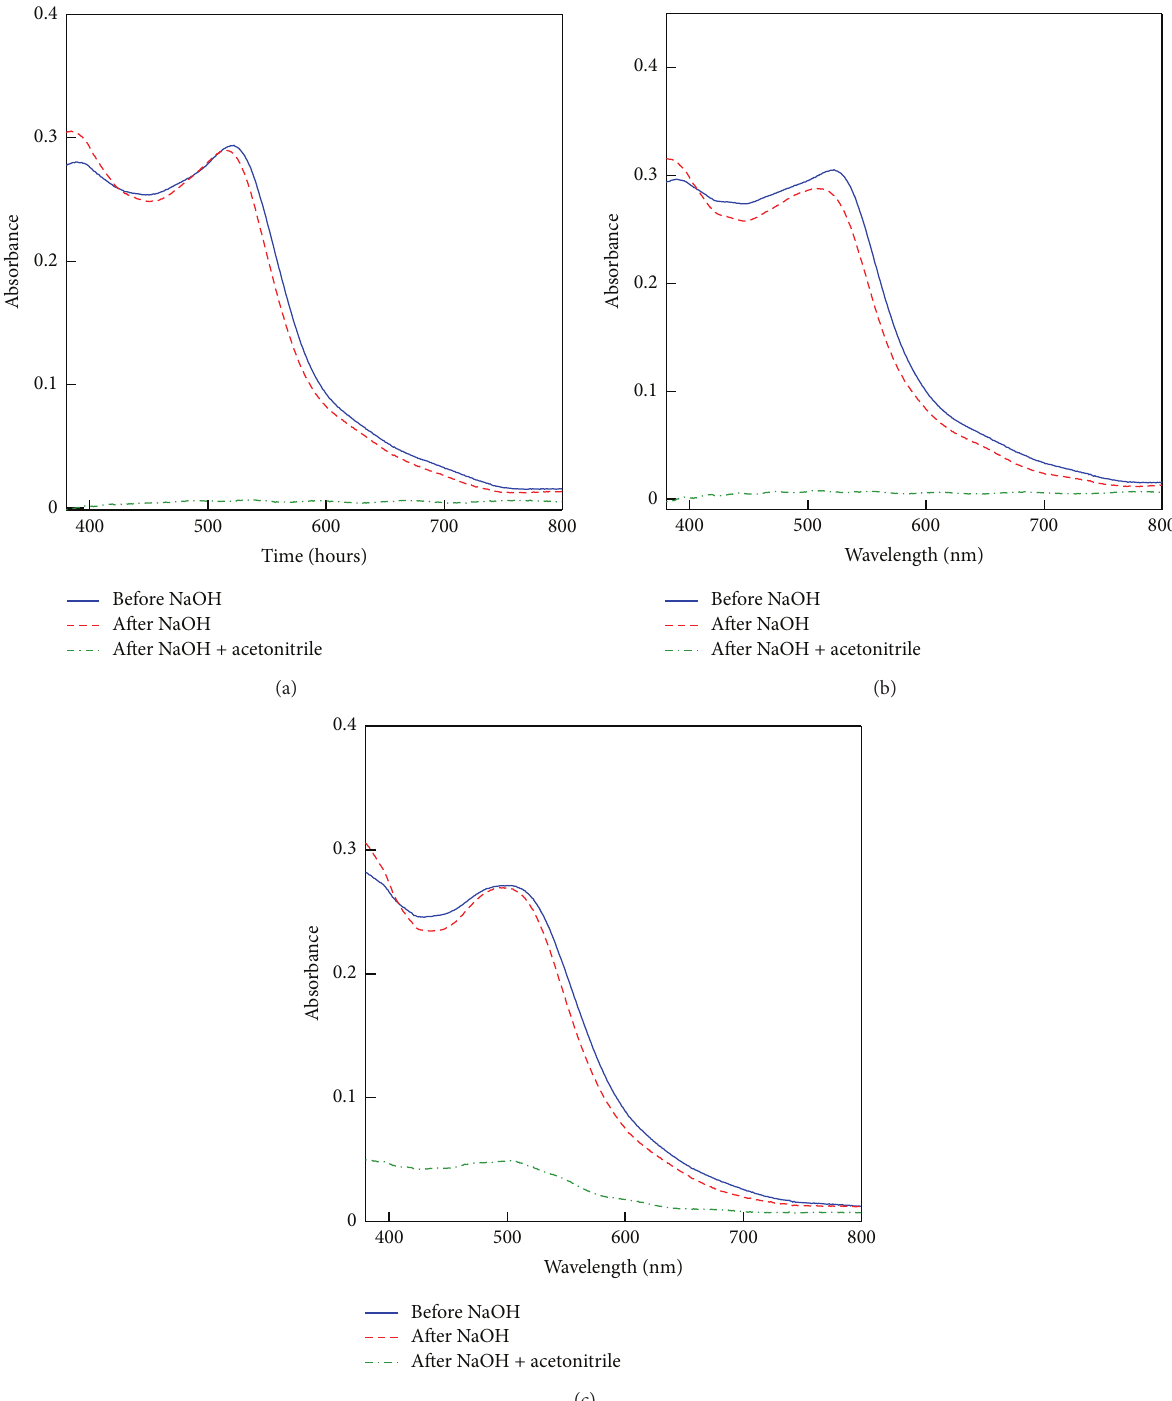
Figure 6: Absorption spectra of double-bond-edged Ru-dye (SG1051) adsorbed nanocrystalline-TiO 2 electrodes without heating (a) and after the heating on a hot plate at 125 ∘ C (b) and 250 ∘ C (c). Each dyed electrode was dipped in NaOH aq. and acetonitrile successively, and the difference of absorbance was